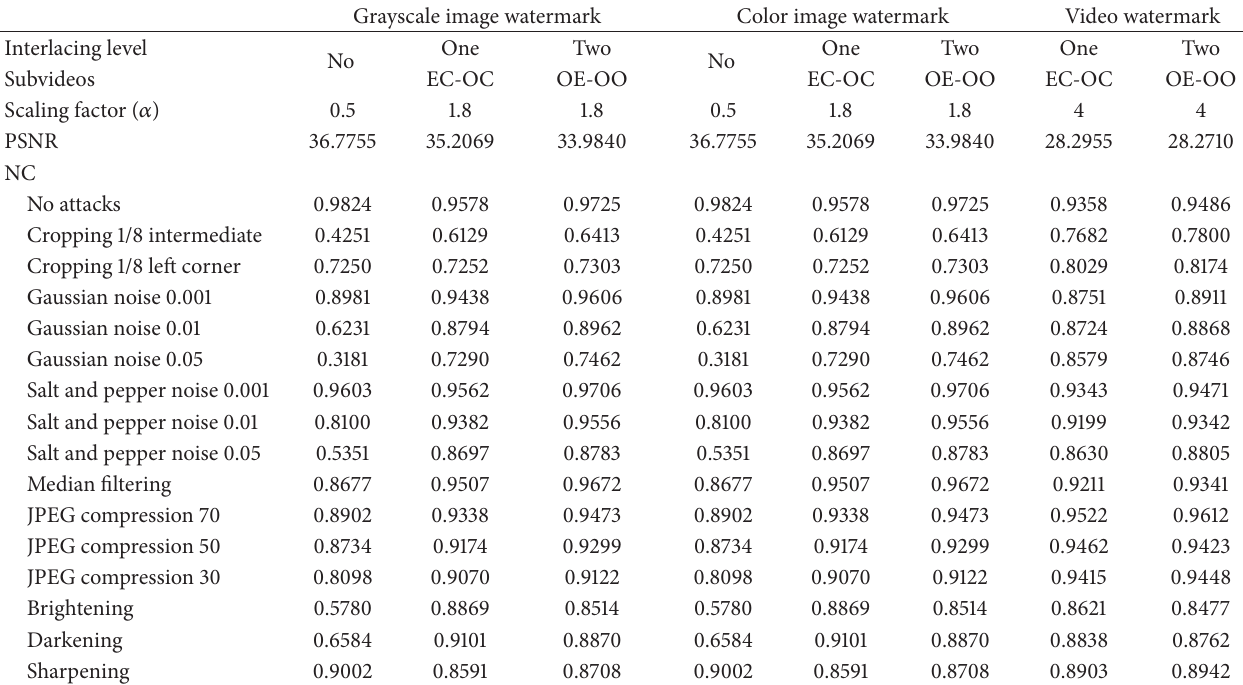
Table 2: Multiple Watermarks (Gray Image, Color Image and Video).